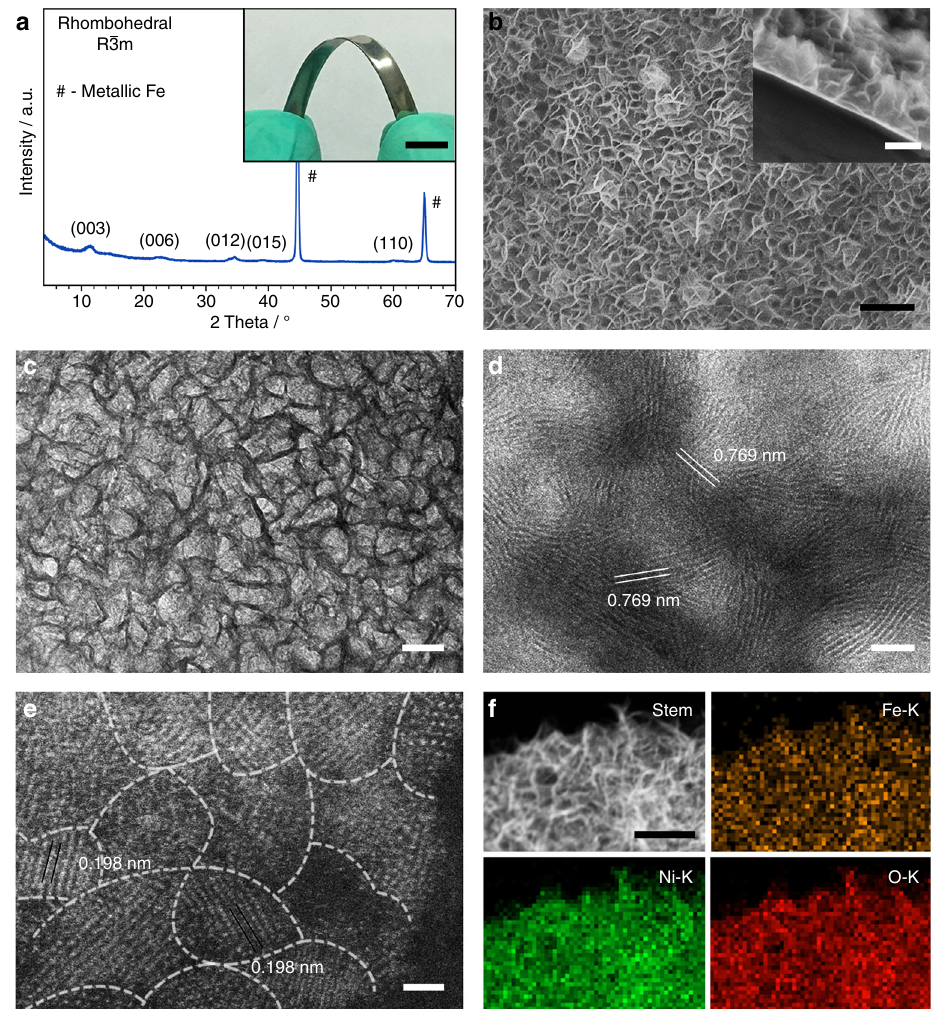
Fig. 2 Structural Characterizations of the electrodes. a XRD pattern of the material obtained by the corrosive treatment of iron plate in the aqueous solution containing Ni 2 + cations, with its digital image shown in the inset. Scale bar, 1 cm. b Top-down and cross-section (inset) SEM images of the material. Scale bars, 400 nm in b and 200 nm in the inset. c TEM, d HRTEM, and e HAADF-STEM image of the LDH thin fi lm on the surface of iron plate. f STEM image of the LDH thin fi lm and the corresponding elemental mapping images. Scale bars, 50, 5, 1, and 200 nm in c , d , e and f ,